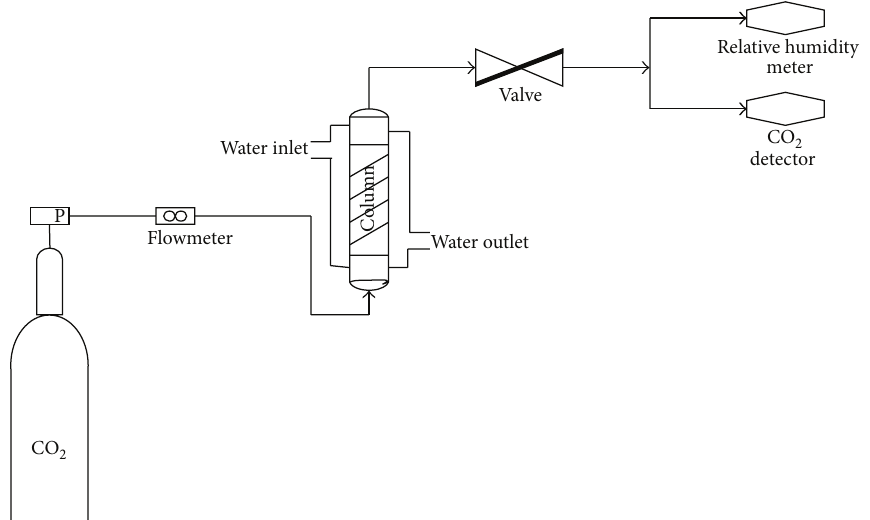
Figure 1: Apparatus used for the adsorption kinetics study.